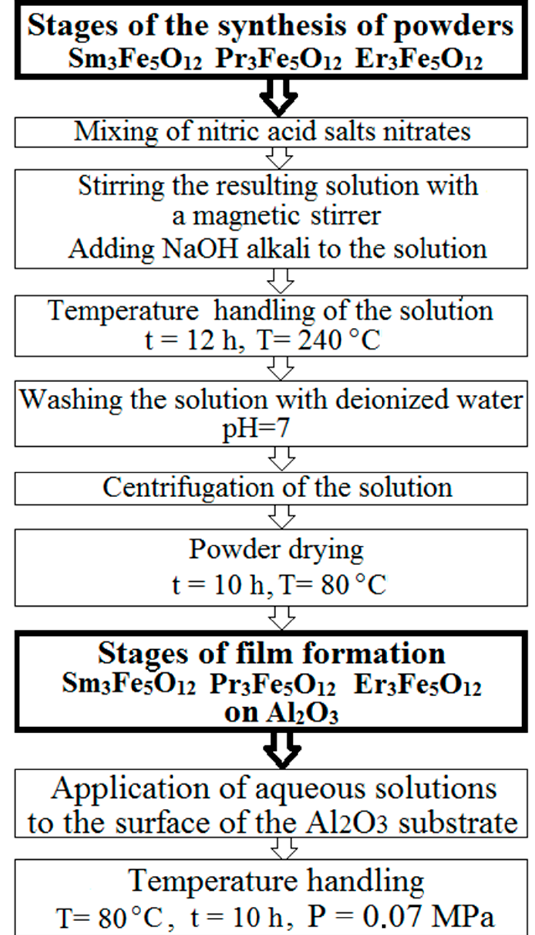
Figure 1. Stages of synthesis of nanostructured powders and films of Sm 3 Fe 5 O 12 , Pr 3 Fe 5 O 12 , and Er 3 Fe 5 O 12 .